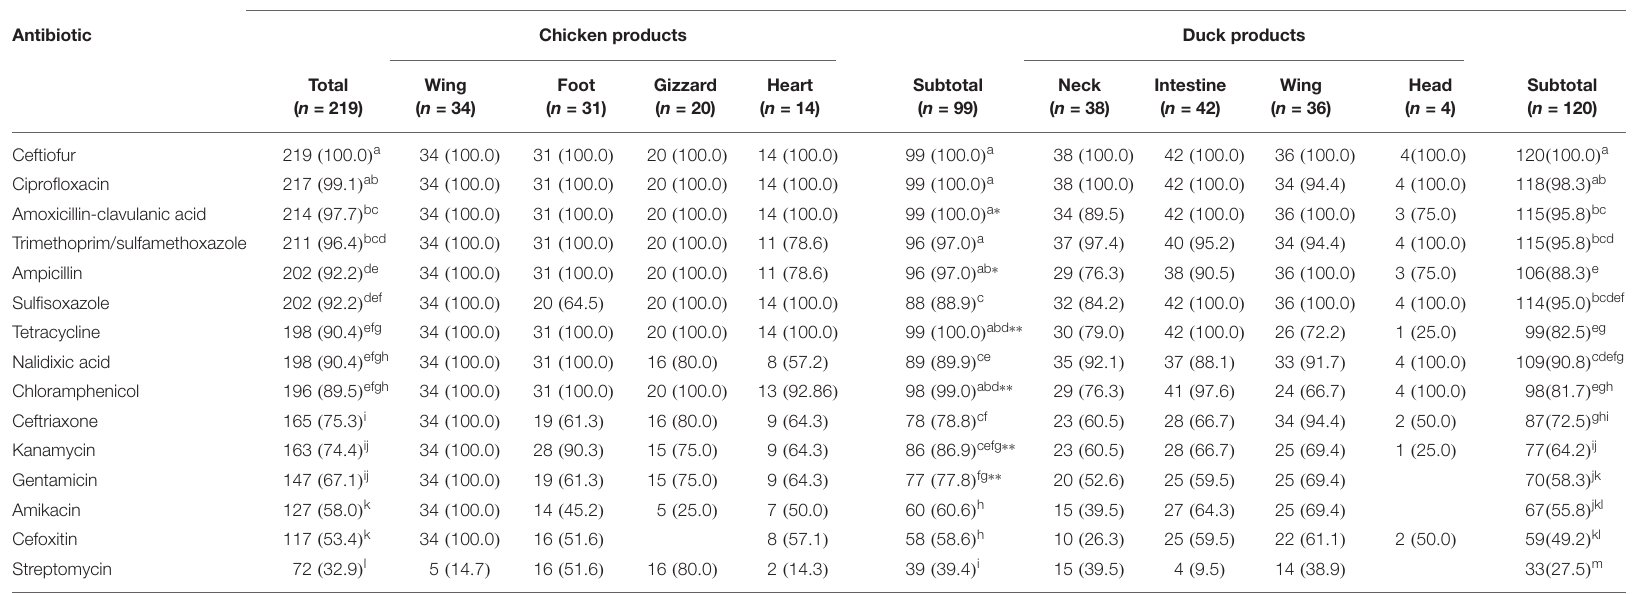
TABLE 5 | Antibiotic susceptibility of Salmonella isolates from